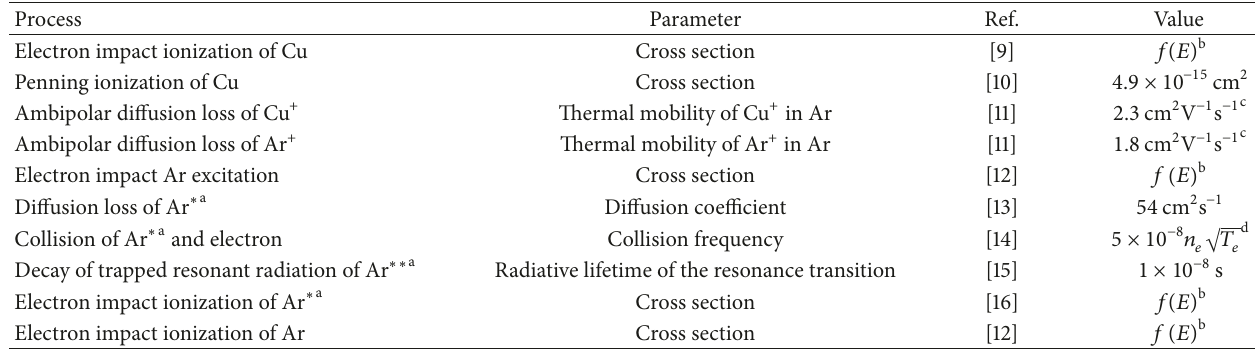
Table 1: A list of processes included in global model and their